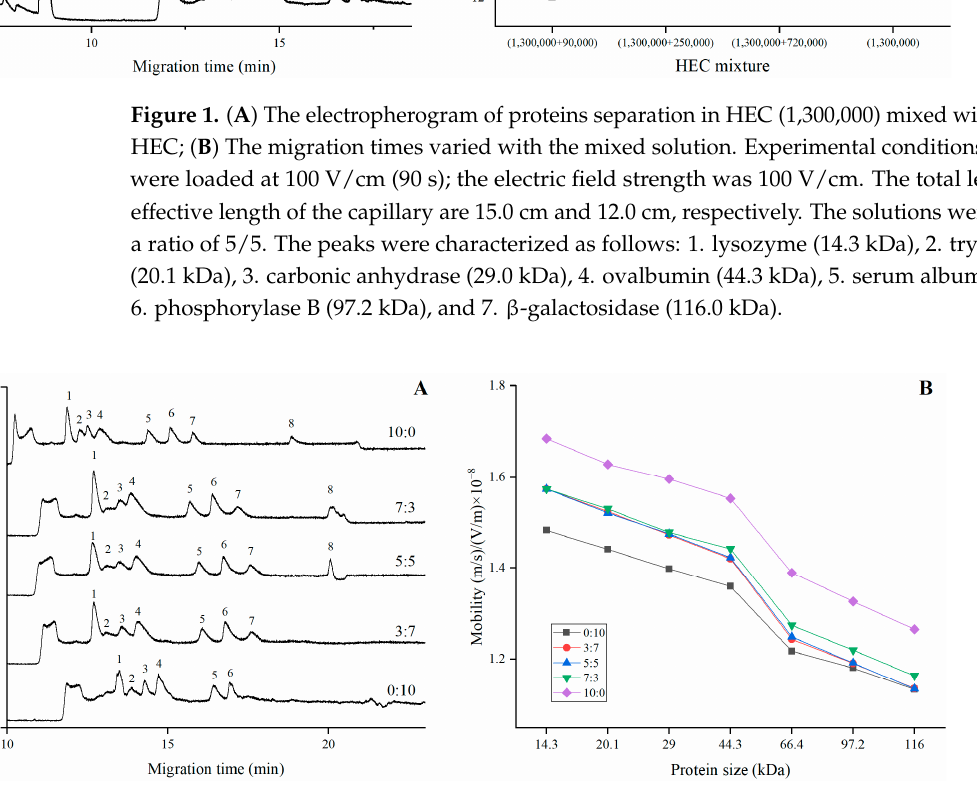
Figure 2. ( A ) The electropherogram of proteins separation in mixed HEC (1,300,000/250,000) solu- tion with different ratios; ( B ) The mobility varied with the protein size in the mixed solution. Other electrophoretic conditions were the same as those in Figure 1. The peaks were characterized as fol- lows: 1. Lysozyme (14.3 kDa), 2. Trypsin inhibitor (20.1 kDa), 3. Carbonic anhydrase (29.0 kDa), 4. Ovalbumin (44.3 kDa), 5. Serum albumin (66.4 kDa), 6. Phosphorylase B (97.2 kDa), 7. B-galactosidase (116.0 kDa), and 8. Myosin (200 kDa).